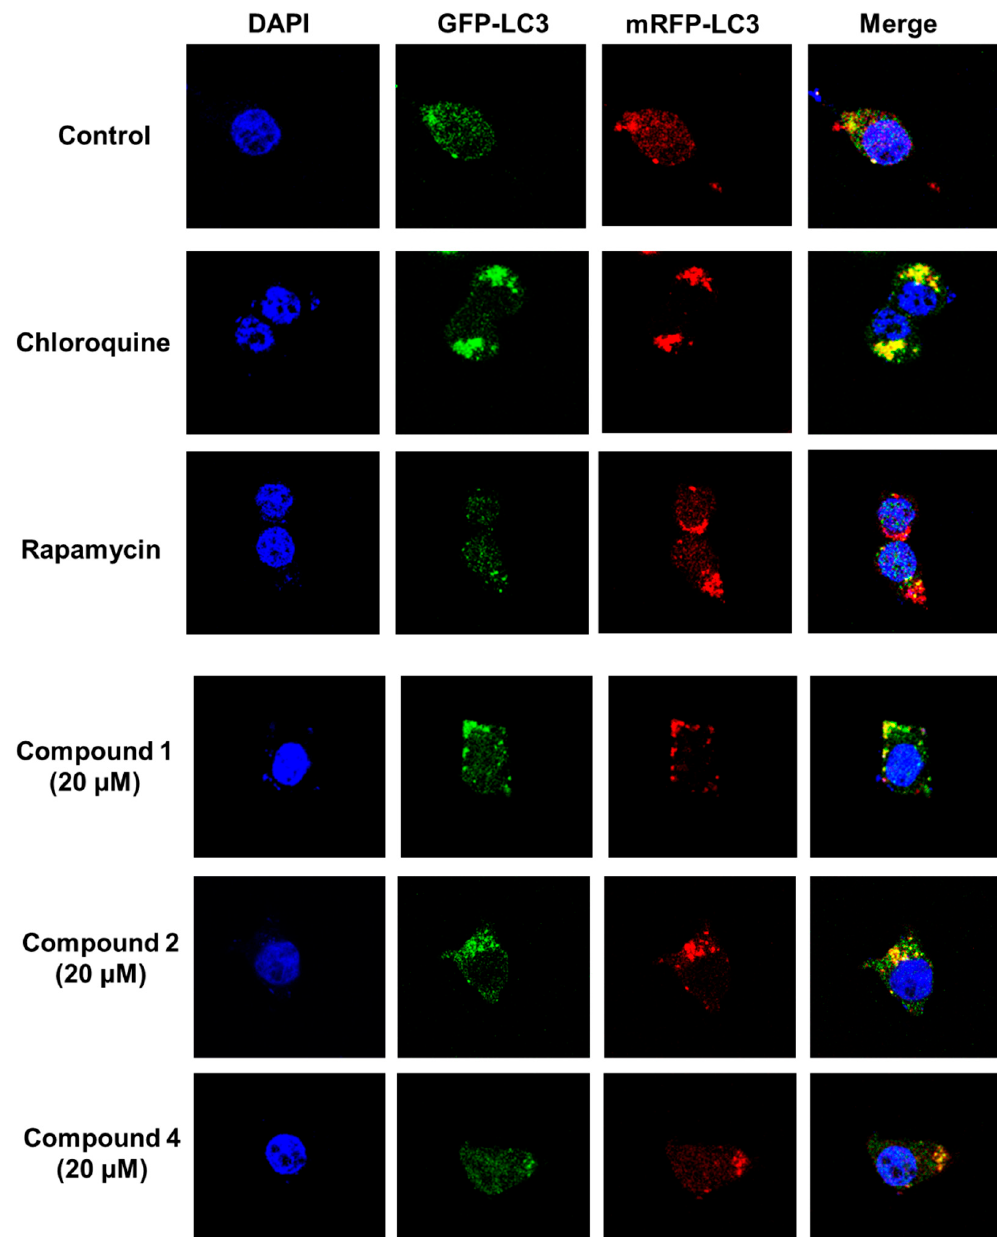
Figure 6. The GFP-mRFP-tagged LC3 punctuates images with the treatment of compounds. HEK293 cells were treated with autophagy-regulating 1 , 2 , and 4 . The LC3 puncta were detected using confocal microscopy.